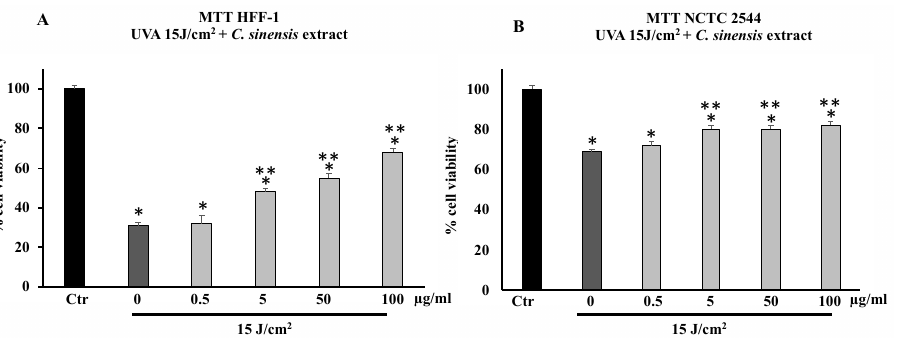
Figure 2. Cell viability in HFF-1 ( A ) and NCTC 2544 ( B ) cells untreated (Ctr) and treated for 4 h with C. sinensis extract at different concentrations (0.5–5–50–100 µg/mL) and irradiated with 15 J/cm 2 of UVA. Values are the mean ± S.D. of five experiments in triplicate. * Significant vs. untreated control cells: p < 0.001; ** Significant vs. untreated irradiated control cells: p < 0.001. Cell viability of HFF-1, reduced by UVB irradiation at 25 mJ/cm 2 and 50 mJ/cm 2 , was